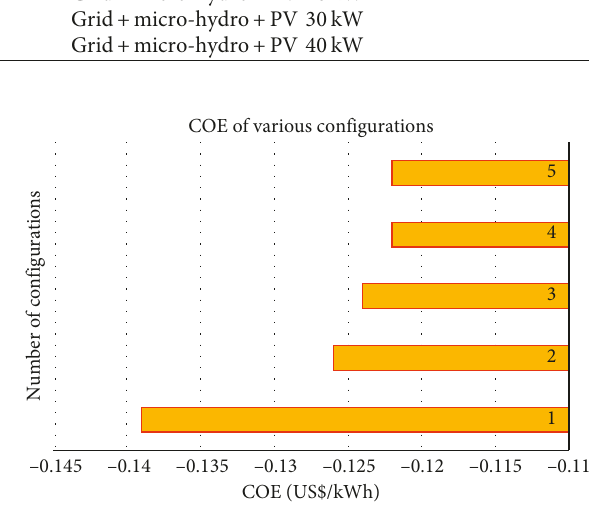
Figure 21: COE for various configurations of the hybrid power plant systems. Table 6: NPC for various configurations of the hybrid power plant